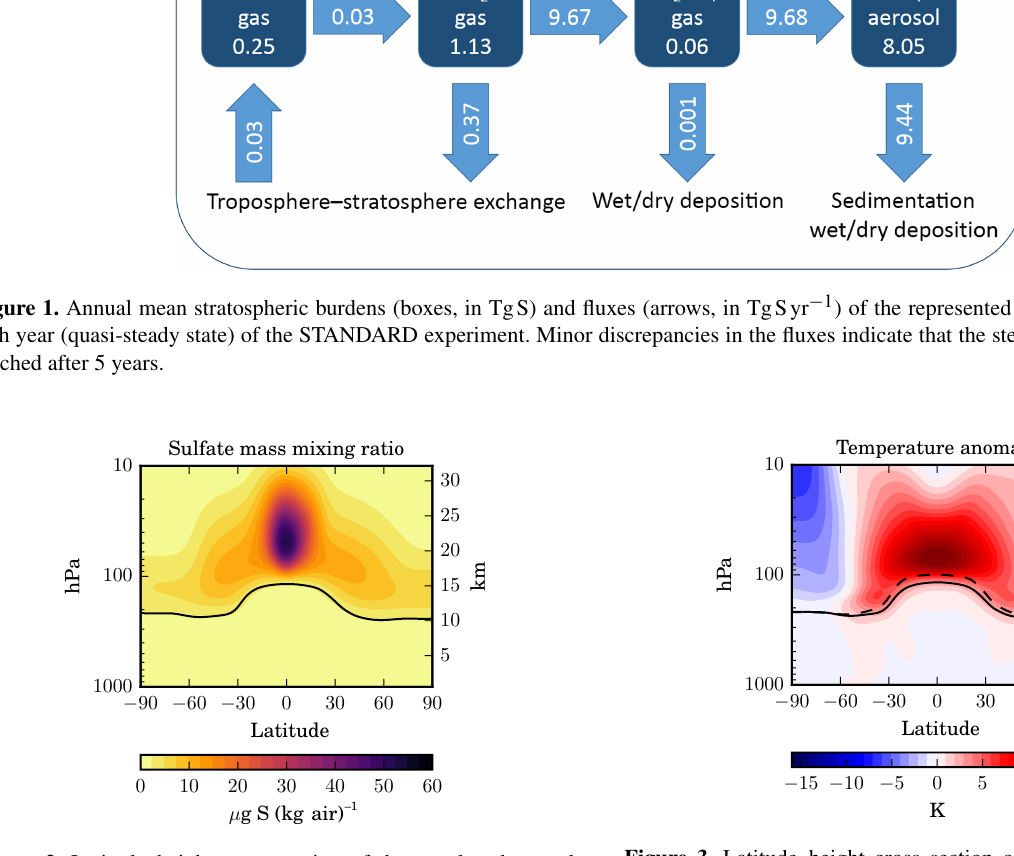
Figure 2. Latitude–height cross section of the zonal and annual mean sulfate aerosol mass mixing ratio (in µgS(kgair) − 1 ) for the STANDARD experiment.